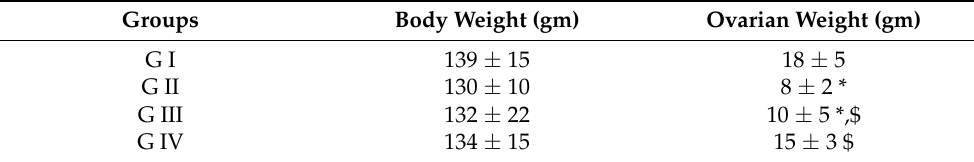
Table 1. Body weight and ovarian weight in different groups. Groups